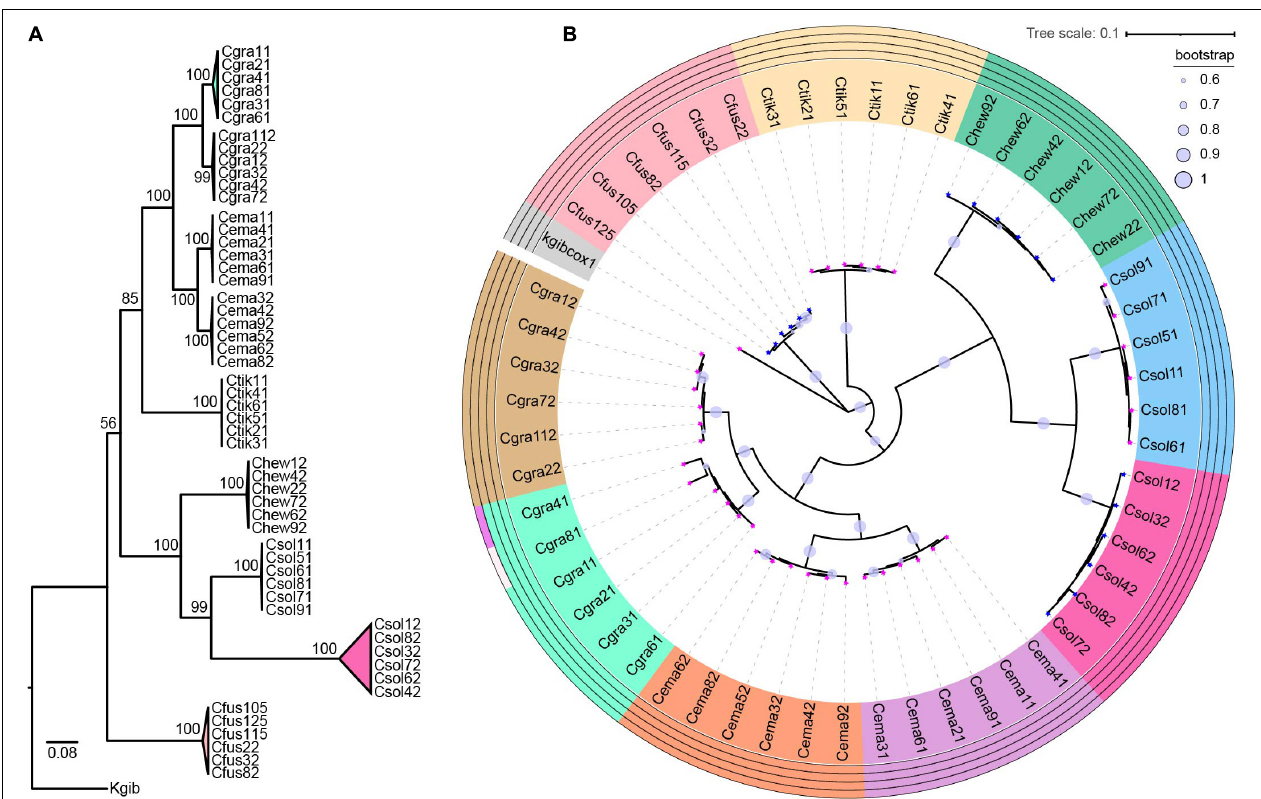
FIGURE 1 | Host phylogeny and molecular species delimitation. (A) Phylogenies of Ceratosolen by ML method based on CO1 gene fragments and ITS2 sequences. (B) According to four methods of ABGD, jMOTU, bPTP, and GYMC, all the samples were defined as nine clades. Species delimitation results are shown in the outer circles. At the tip of the branch, the magenta pentagram indicates Wolbachia -infected, and the blue pentagram indicates uninfected. Fig wasp species are abbreviated as follows: Cgra, Ceratosolen gravelyi ; Cfus, Ceratosolen fusciceps ; Ctik, Ceratosolen sp.; Chew, Ceratosolen hewitti ; Cema, Ceratosolen emarginatus ; Csol, Ceratosolen solmsi ; Kgib, Kradibia gibbosae